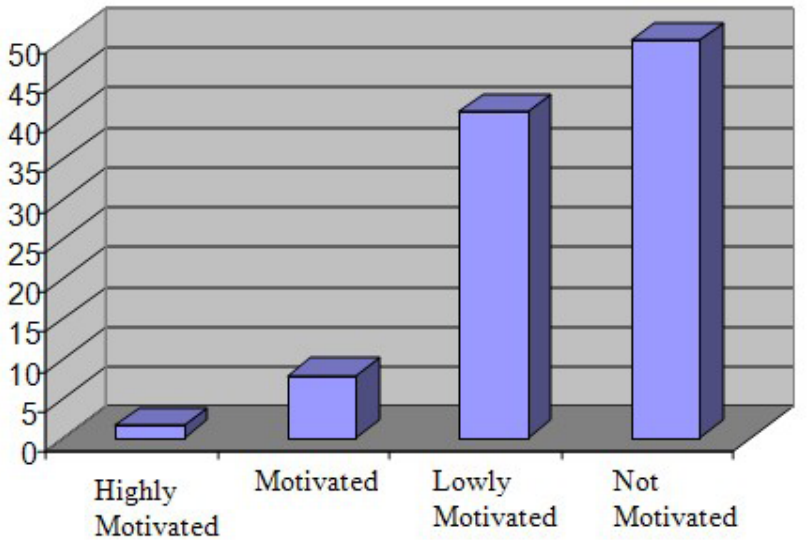
Figure 4 . Levels of motivation of lecturers in